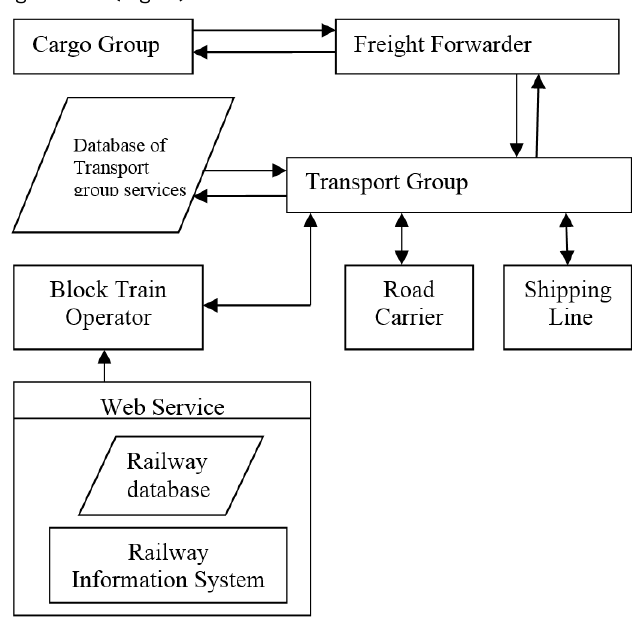
Fig. 4. Sample of the use of web